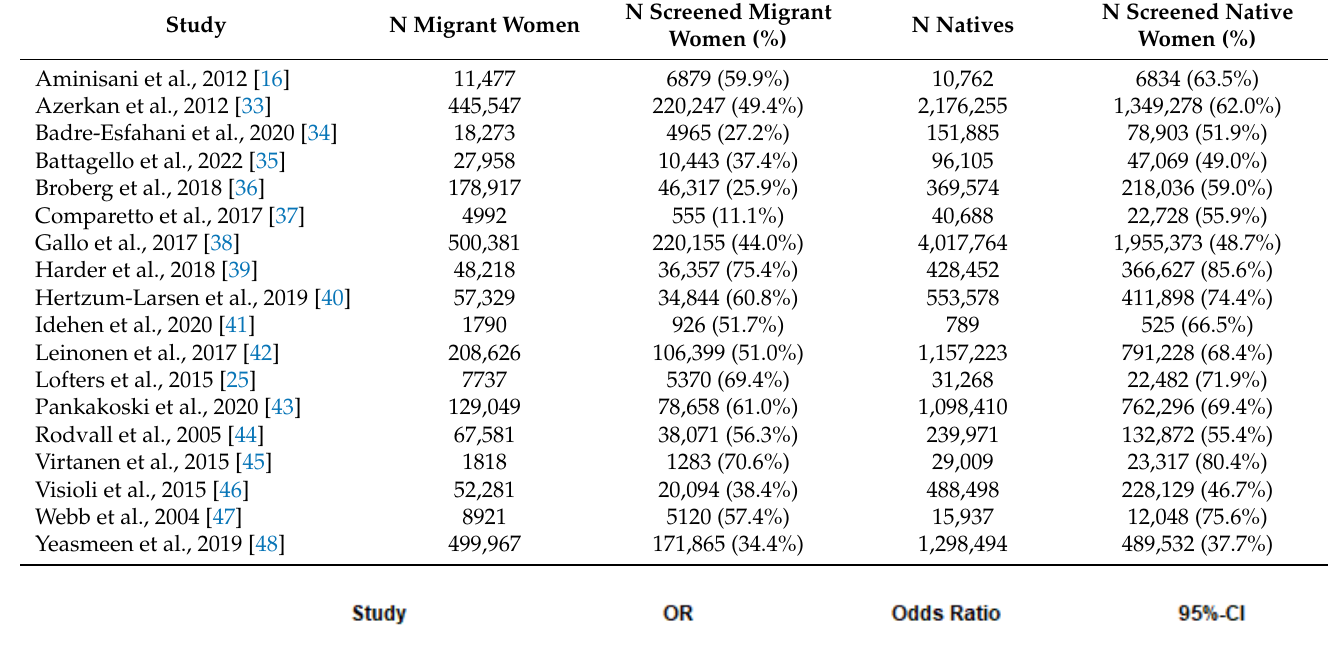
Table 3. Sample sizes for migrants and natives included in the studies.